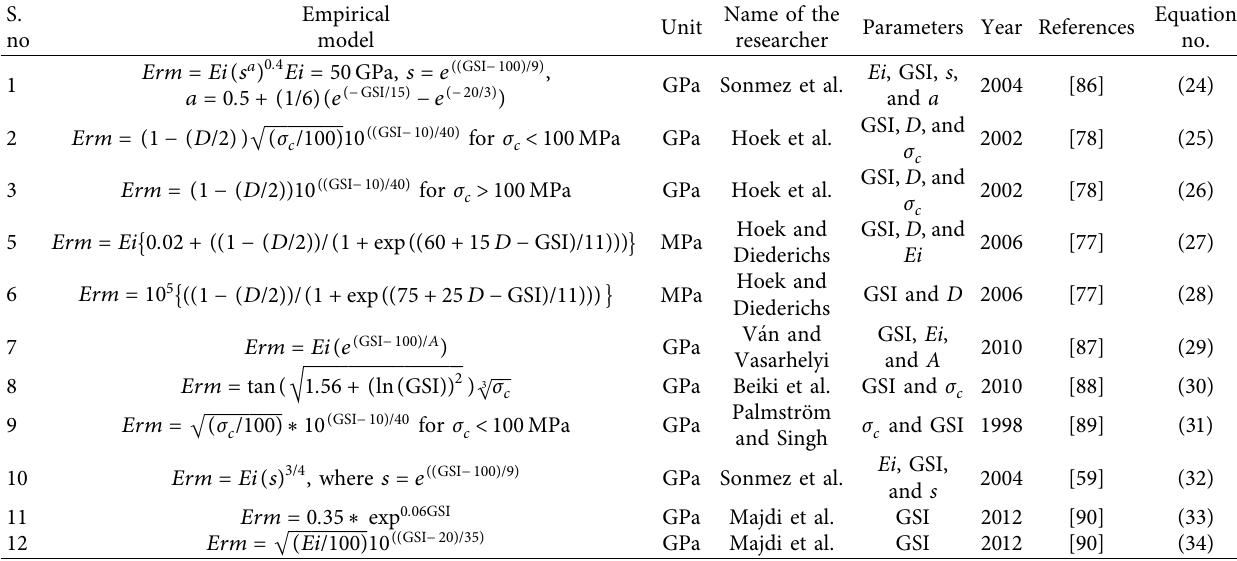
Table 2: Empirical models for rock mass deformation